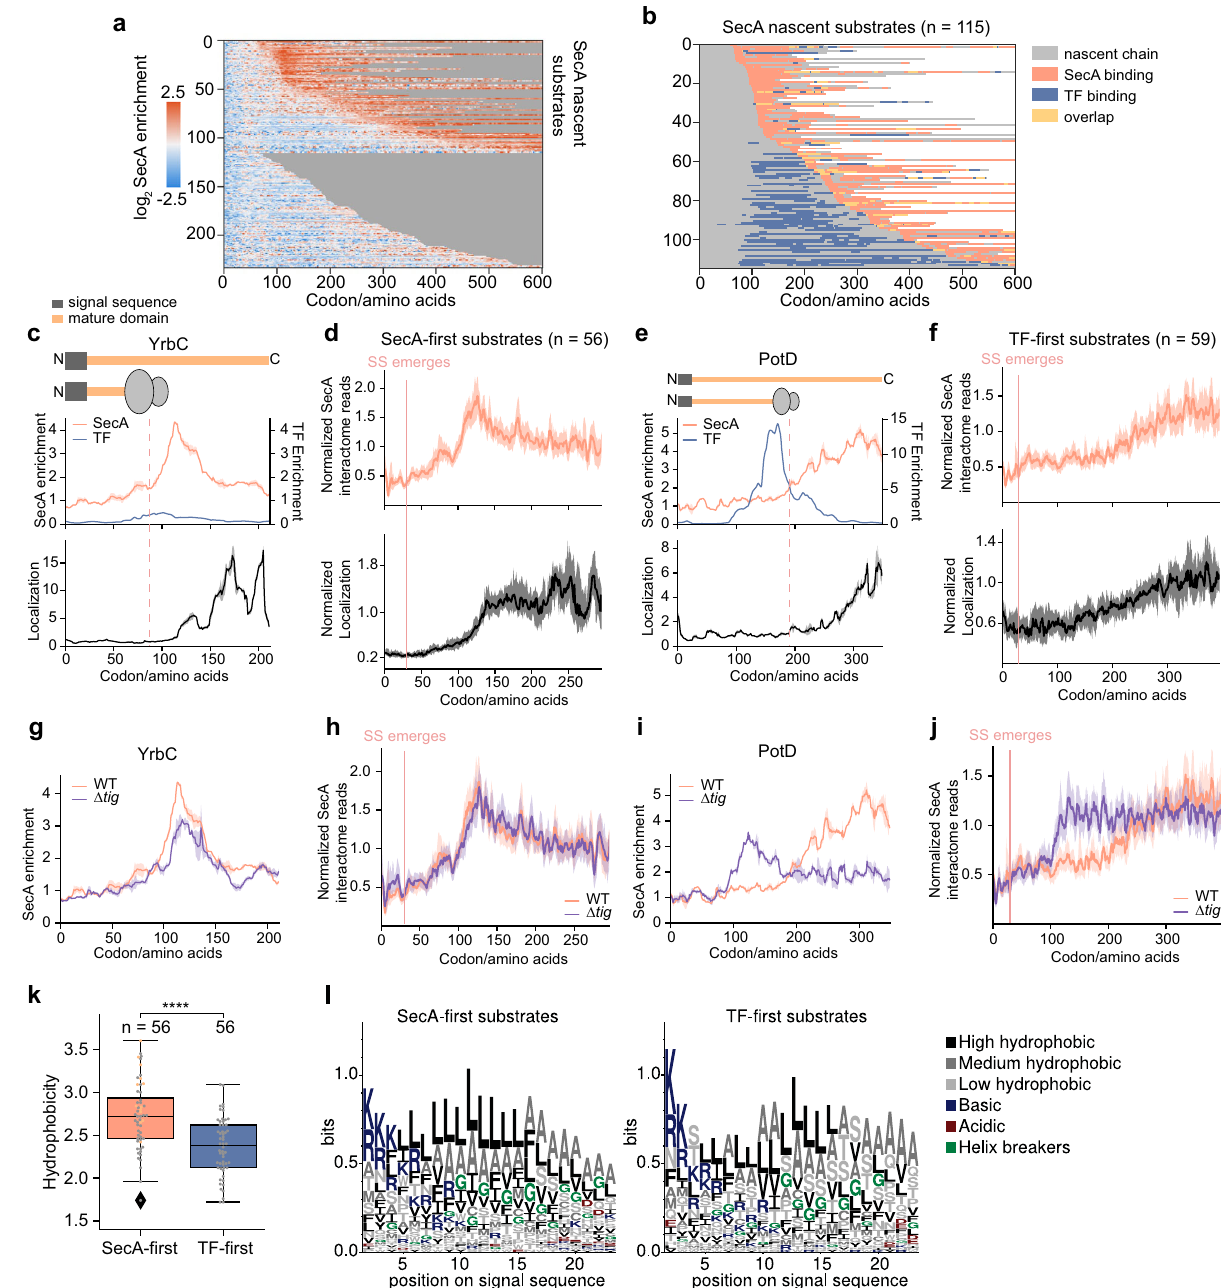
Fig. 4 SecA engagement on nascent secretory proteins is delayed by trigger factor. a Heatmap of log 2 SecA enrichment at each codon of all secretory proteins. b Heatmap of SecA and TF binding 21 on SecA-interacting nascent secretory proteins, sorted by increasing distance from the start codon to the onset of SecA binding. c , e Representative SecA and TF 21 interaction pro fi les and ribosome localization pro fi les of a SecA- fi rst ( c ) and a TF- fi rst ( e ) substrate. Protein topology is shown above, with signal sequence in dark grey and mature domain in yellow. d , f Metagene SecA interactome pro fi le and ribosome localization pro fi le of SecA- fi rst ( d ) and TF- fi rst ( f ) substrates aligned to the N-terminus of signal sequences. g , i Representative SecA interaction pro fi les of a SecA- fi rst ( g ) and a TF- fi rst ( i ) substrate. Protein topology is shown above and colored as in c . h , j Metagene SecA interactome pro fi le of SecA- fi rst ( h ) and TF- fi rst ( j ) substrates aligned to the N-terminus of signal sequences. k , Hydrophobicity of the signal sequences of SecA- fi rst and TF- fi rst substrates. Yellow dots indicate substrates that also engage with SRP. The signal sequences of Ppk, SpeA and HybC cannot be faithfully predicted and are excluded from the analysis. Source data are provided in the “ Source Data ” fi le. l , WebLogo representations of the amino acid compositions of the signal sequences of SecA- fi rst and TF- fi rst substrates aligned to the second amino acid. In c , e , g , i , solid lines show the mean values, and shaded areas show the range of data from two independent biological replicates. In d , f , h , j , solid lines show the mean values, and shaded areas show the 95% CI. In k , the centre lines show the median, the boxes show the range between the upper and lower quartiles of data, and the whiskers indicate 1.5x the interquartile range. P = 3.716e − 6 , from two-sided Wilcoxon rank-sum